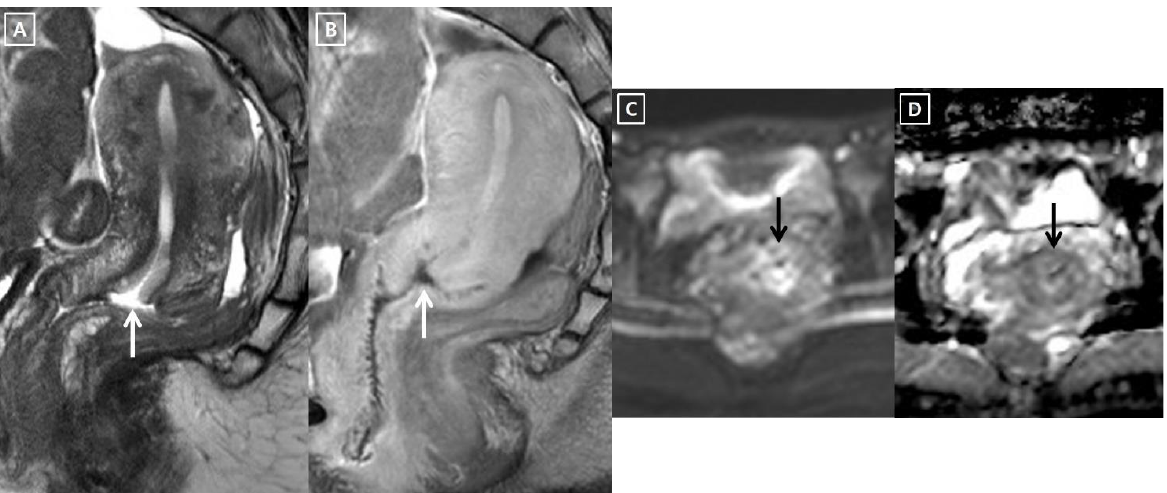
Figure 2. A 41-year-old woman with invisible IB1 cervical cancer on 3T MRI. ( A , B ). T2-weighted and delayed contrast-enhanced sagittal MR images do not show residual cancer but a conization defect (white arrow). The radical hysterectomy specimen demonstrated a 2.0 mm residual SCC and 22.2% invasion depth. There was no invasion or metastasis into the parametrium, vagina, LVS, and LN. ( C , D ). The diffusion-weighted axial MR image shows a hyperintense cervix (black arrow). However, it does not show a low ADC value (black arrow) on the apparent diffusion coefficient map image. Therefore, cervical cancer is not visible on the MR images.